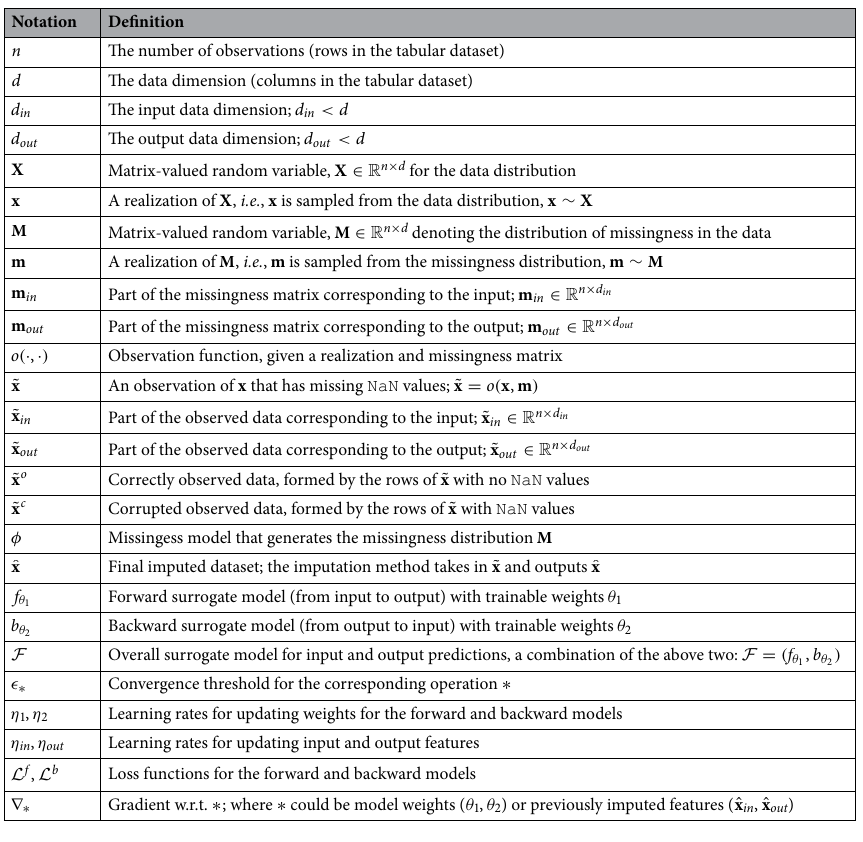
Table 1. Notations used in